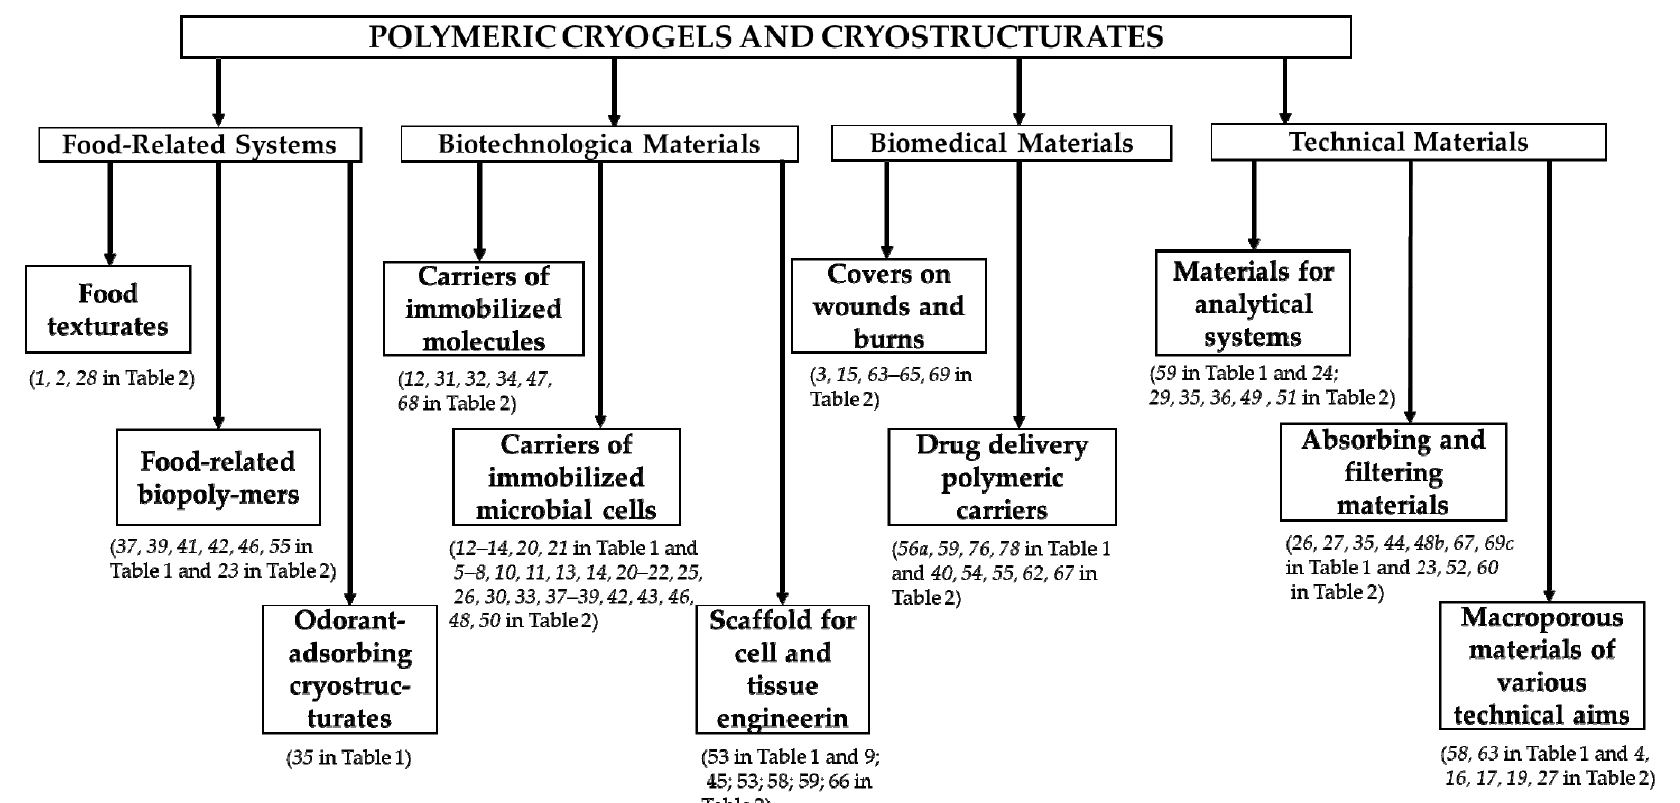
Figure 4. Schematic diagram showing the applied R&D activities of the research with respect of the developed in IOEC cryogenically-structured materials .